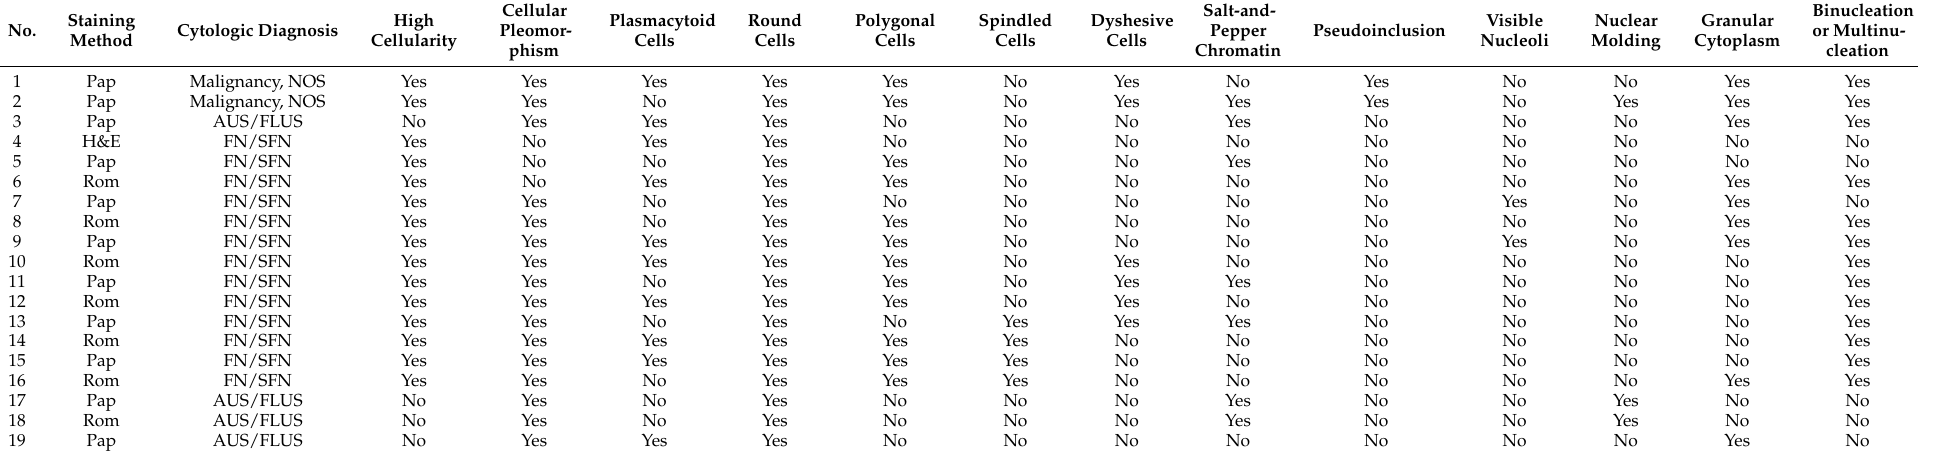
Table 1. Cytopathological characteristics of all the cytologic specimens with incorrect diagnoses (excluding unsatisfactory